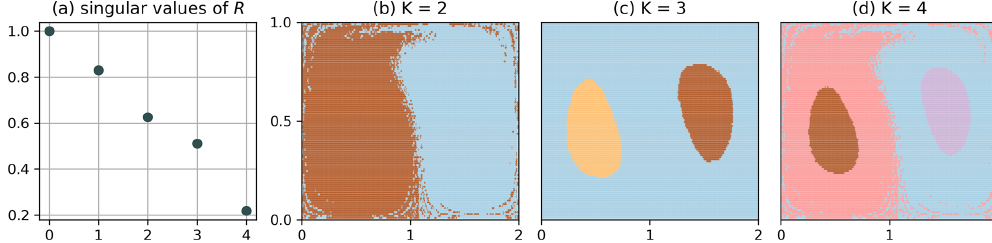
Figure 4. Clustering of Q with (cid:49)x = 2 / 3, (cid:49)y = 1 / 3 of the full data set, i.e. N = 20000 and τ = 201. The most dominant structure is still visible to high accuracy, although the problem is effectively